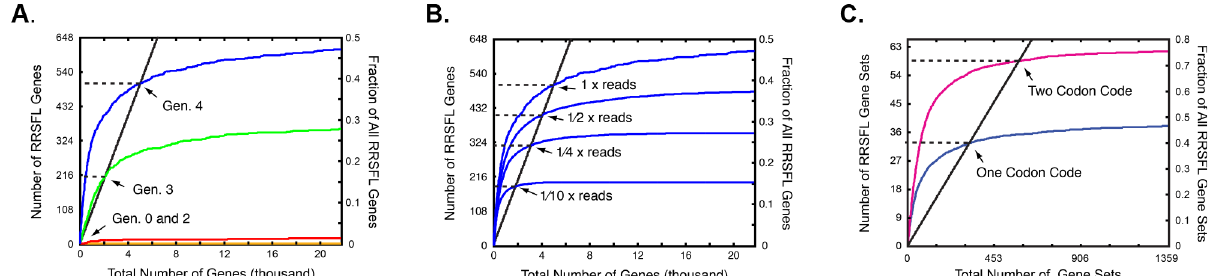
Fig 5. Accuracy of hit detection. The plots show the number of RRSFL encoding genes (y-axis) contained within the top N total genes (x- axis) of a list ranked by enrichment ratio. If the gene ranking had been perfect, the curves would have gone straight up the y-axis and then cut right on the x-axis at the top of the plot. The solid black line shows how RRSFL genes accumulate at a 90% false discovery rate (i.e. when every tenth gene is a hit). The y-value at the intersection of each curve with the solid black line corresponds to the number of RRSFL genes that would have been detected below a 90% false discovery threshold. A. Improved gene ranking over successive generations. The number of RRSFL genes at the top of ranked lists from the zeroth (yellow), second (red), third (green) and fourth (blue) generations is shown. None of the RRSFL genes could be detected below a 90% false discovery threshold in the zeroth or second generations, whereas 207 and 505 out of 1296 total could be detected in the third and fourth generations respectively. B. Dependence of gene ranking on sequencing depth. The effect of using increasingly small fractions of the total sequencing data to rank genes is shown. 505, 416, 319 and 188 of the RRSFL genes could be detected below a 90% false discovery threshold given 3 million, 1.5 million, 0.75 million and 0.3 million sequencing reads respectively. The discovered fraction of RRSFL genes grew roughly in proportion to the square root of the number of reads. C. Improved gene ranking with a redundant genetic code. The ranking of RRSFL gene sets based on 187500 gene reads and a two codon-per- amino acid genetic code is shown. In one case, the reads used for the analysis were restricted to genes containing a single codon from each codon pair. In this single-codon case, 32 of the 81 RRSFL genes sets could be detected below a 90% false discovery threshold. Alternatively, an identical number of gene reads were used for the analysis, but the reads included genes containing both codons of each codon pair. In the two-codon case, 58 of the 81 RRSFL genes sets could be detected. The two-codon genetic code revealed 70% of the RRSFL gene sets, while the one-codon code revealed only